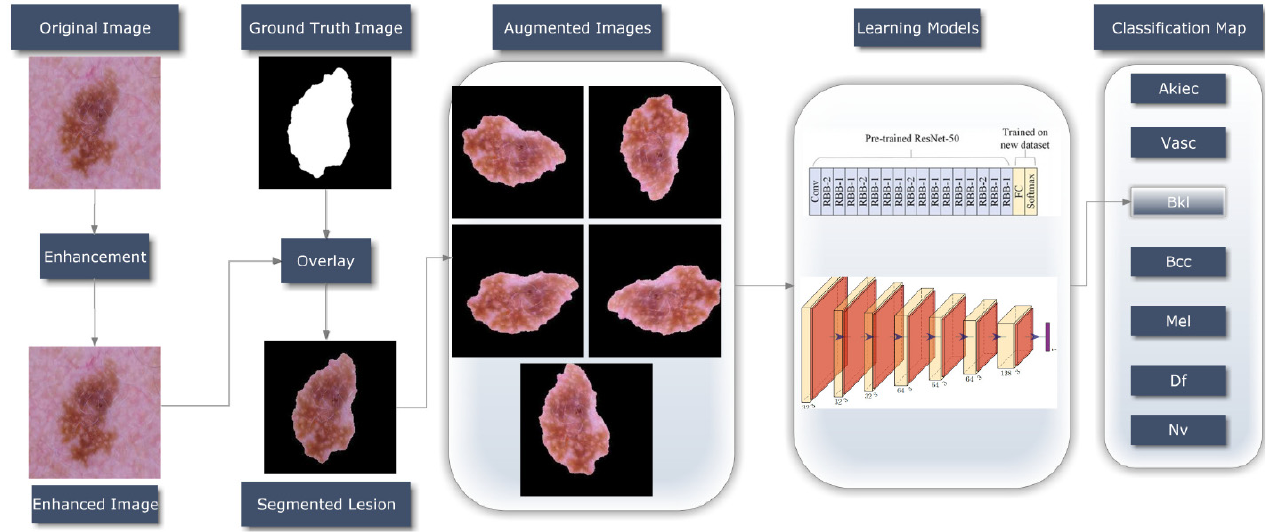
Figure 3. An overall process of how to recognize skin cancer.